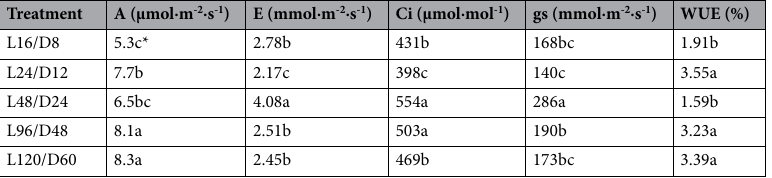
Table 2. Photosynthetic parameters of lettuce leaves exposed to different L/D cycle treatments of RB. Values for the same parameter with different letters significantly differ at the 5% level (by Tukey’s test, n = 3). A— Assimilation rate; E—Transportation rate; Ci—Internal CO 2 ; gs—Stomatal conductance; WUE—Water use efficiency. L/D—light/dark. L16/D8—16 h light/8 h dark, L24/D12—24 h light/12 h dark, L48/D24—48 h light/24 h dark, L96/D48—96 h light/48 h dark, L120/D60—120 h light/60 h dark.